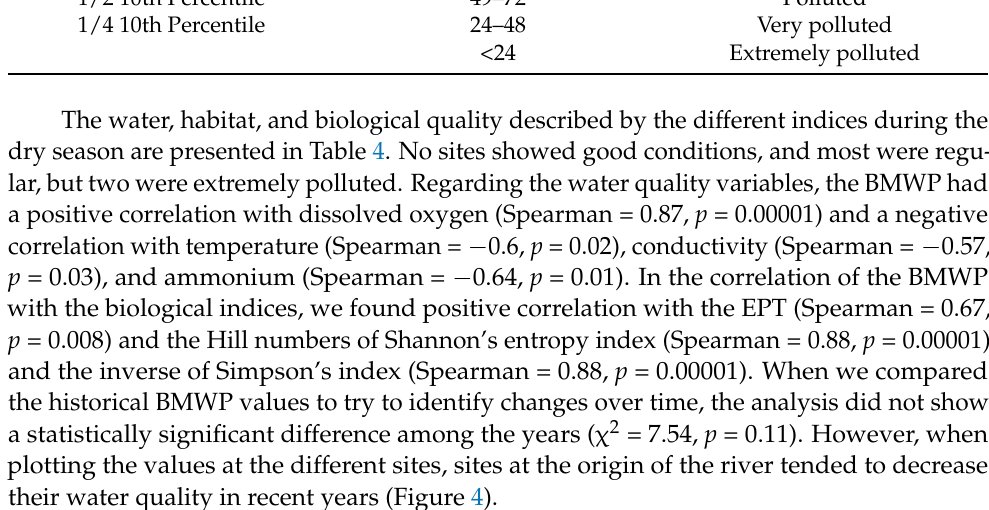
Table 3. Water quality categories of the Duero river from the BMWP. Table 4. Average values of the Habitat Quality Index (HQI), the Water Quality Index (NSFWQI), the Ephemeroptera, Plecoptera, Trichoptera index minus Baetidae (EPT-B), and the BMWP, including their interpretation. AntesC = Antes Central de Abastos y DespuésC = Después Central de Abastos. The Grey line indicates sites with contrasting interpretation of the indices.